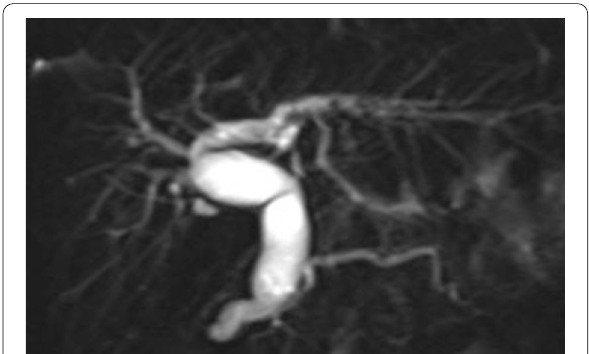
Fig. 1 Preoperative magnetic resonance cholangiopancreatography (MRCP). MRCP showing dilatation of bile duct from the left and right intrahepatic bile ducts to the common bile duct. The gallbladder is not detected on MRCP